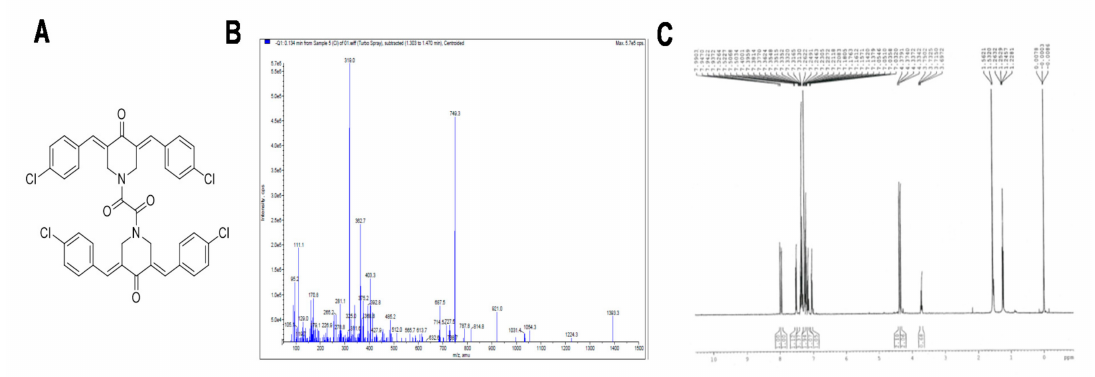
Figure 1. Characterization of ST09. ( A ) Structure of ST09; ( B ) mass spectrometry data of ST09; ( C ) 1HNMR data of